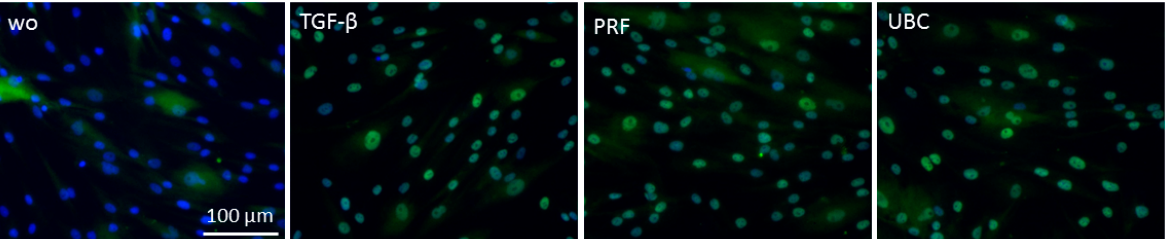
Figure 3. PRF and UBC lysates activated the phosphorylation of Smad3. ( A ) Gingival fibroblasts were exposed to 30% PRF or UBC lysate and TGF- β for one hour following overnight serum starvation. Western blot analysis showed a clear increase in basal Smad3 phosphorylation in response to both PRF and UBC lysates. ( B ) Data indicate the relative changes normalized to Smad3; “wo” indicates without and represents unstimulated cells.